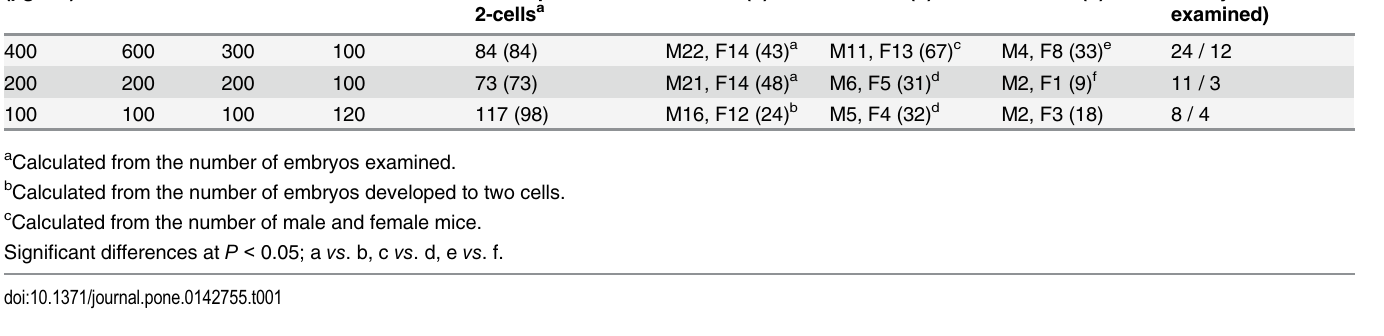
Table 1. Development of mouse embryos with introduced RNAs and ssODN using the TAKE method. Cas9